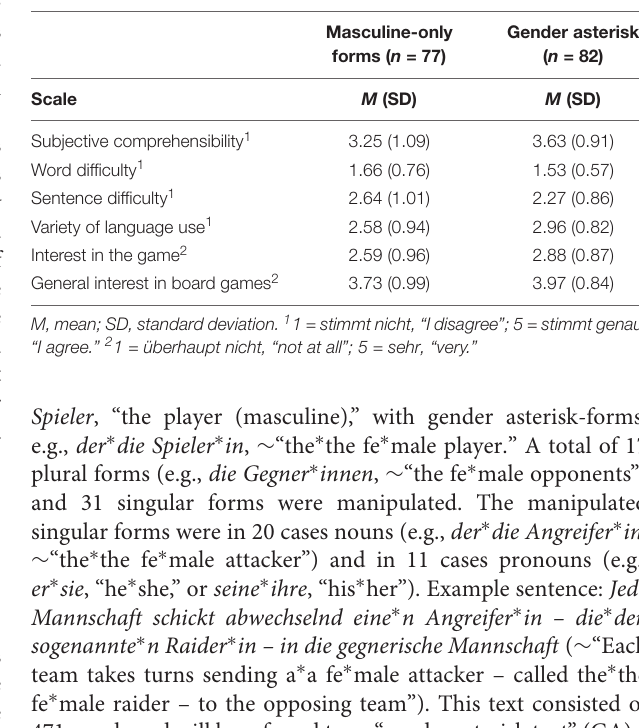
TABLE 2 | Descriptive statistics for the two texts in Experiment